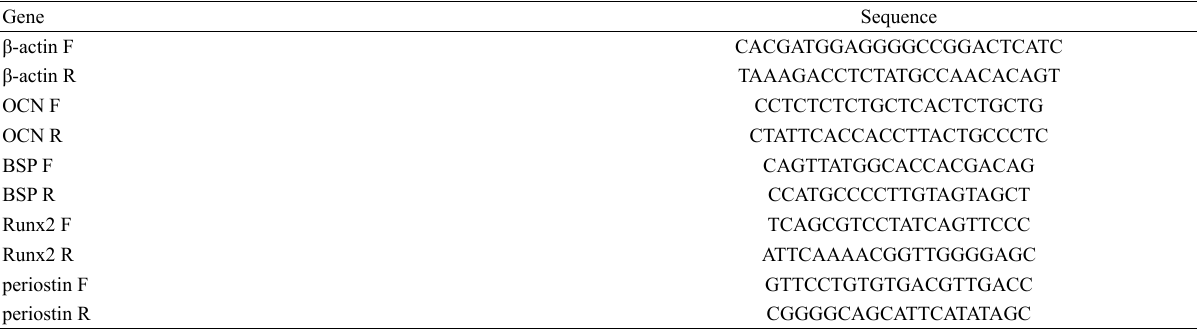
Table 1 ‒ Primer sequences used for real-time